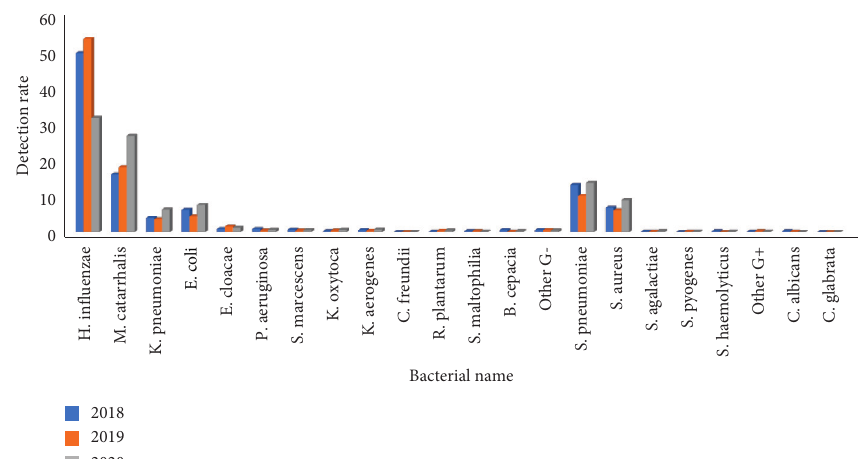
Figure 7: Detection rate of pathogens in lower respiratory tract in the first quarter before and after the pandemic situation of COVID-19